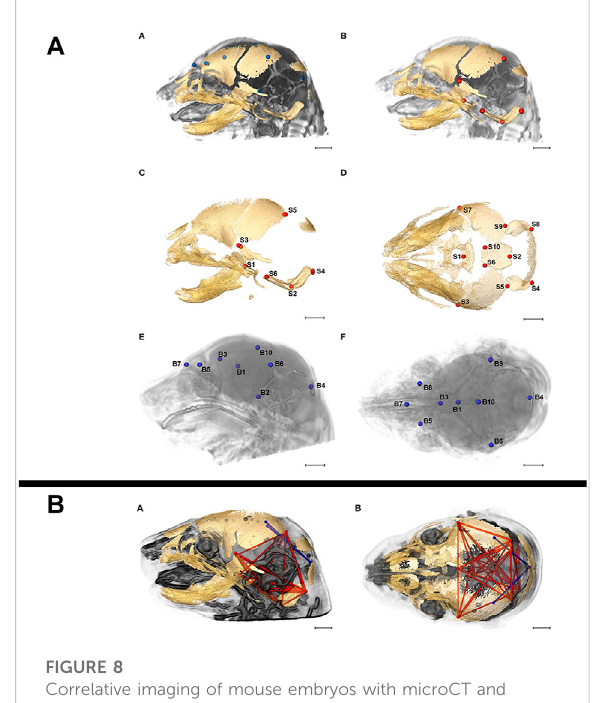
FIGURE 8 Correlative imaging of mouse embryos with microCT and MRI. (A) Skull and brain landmarks set on co-registered microCT and high-resolution MRI data sets. The inter-landmark distances are used in a PCA analysis to assess the integration of skull and brain development. MicroCT reveals bone structure, MRI retrieves brain morphology in formaldehyde- fi xed but otherwise uncontrasted E17.5 mouse embryos (Figure 2 from Motch Perrine et al., 2017, Frontiers in Human Neuroscience 11). (B) Brain (blue) and skull (red) linear distances with statistically signi fi cant different association between Fgfr2c C342Y/+ Crouzon syndrome mice and Fgfr2 +/S252W Apert syndrome mice at E17.5 (Figure 6 from Motch Perrine et al., 2017, Frontiers in Human Neuroscience 11). All images reprinted under the terms of the Creative Commons Attribution